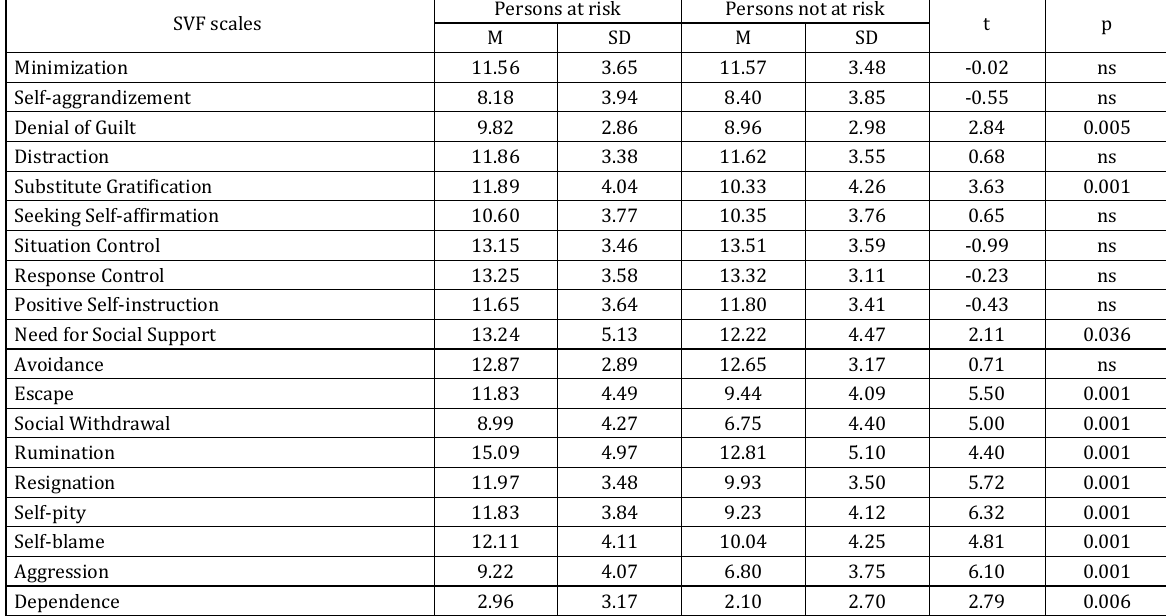
Table 1. A comparison of coping strategies in students at risk and not at risk of mobile phone addiction Persons at SVF scales